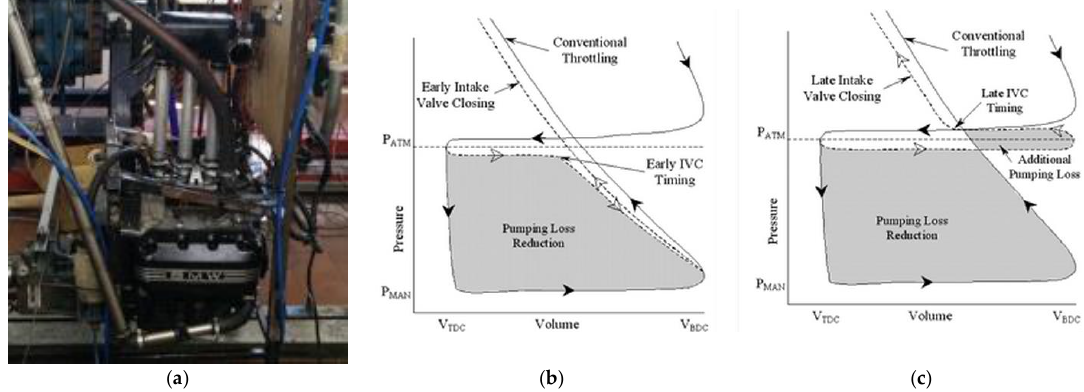
Figure 2. ( a ) Engine in the test dynamometer; pumping losses for early intake valve closure (EIVC) ( b ) and late intake valve closure (LIVC) ( c ) strategies, adapted from [35].